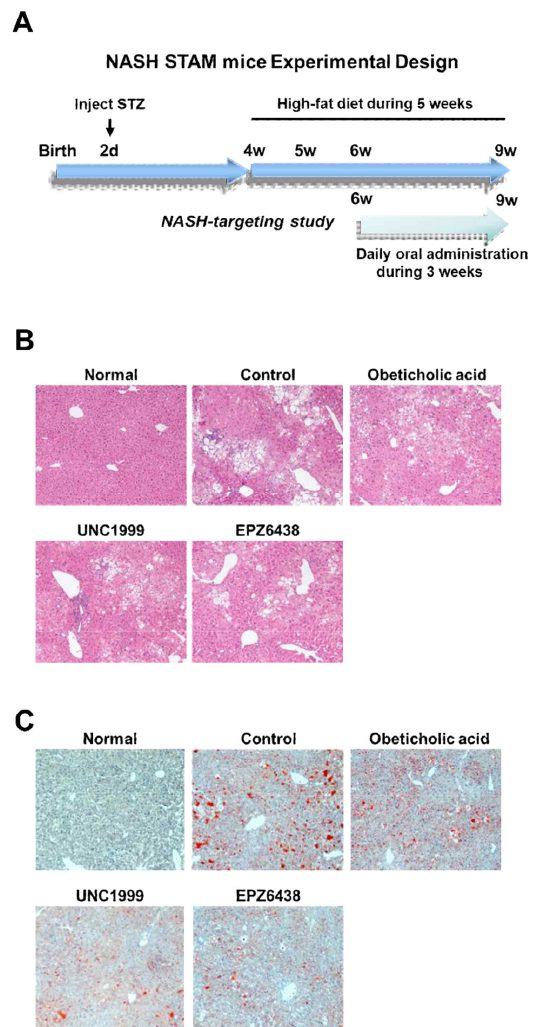
Figure 1. Treatment with Enhancer of Zeste Homolog 2 (EZH2) inhibitors reduces liver steatosis in STAM NASH mice. ( A ) NASH STAM mice experimental design. STAM-Vehicle (Control) were injected with streptozotocin (STZ) on day 2 to induce a diabetic state. Mice were fed a high-fat diet